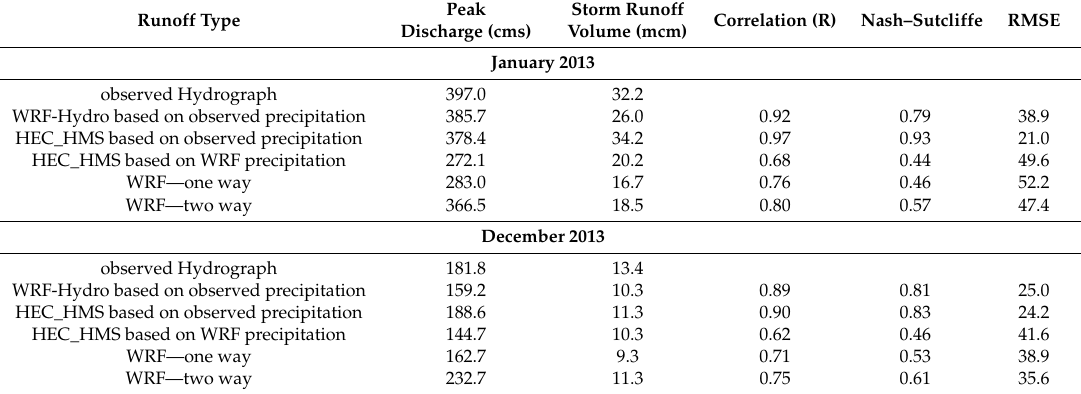
Table 2. Peak discharges, total Storm runoff volumes, correlation, the Nash–Sutcliffe test and RMSE for observed hydrographs at the January and December floods at Ayalon-Ezra hydrometric statin vs. the following simulations for those events: HEC-HMS derived by observed precipitation, WRF-Hydro derived by observed precipitation, HEC-HMS derived by simulated WRF precipitation, WRF-Hydro one way derived by simulated WRF precipitation and WRF-Hydro two way derived by simulated WRF